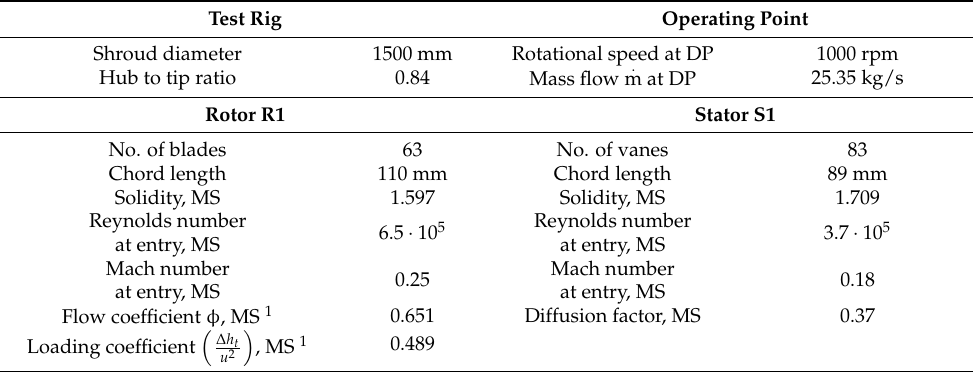
Table 1. Reference setup specifications of the LSRC